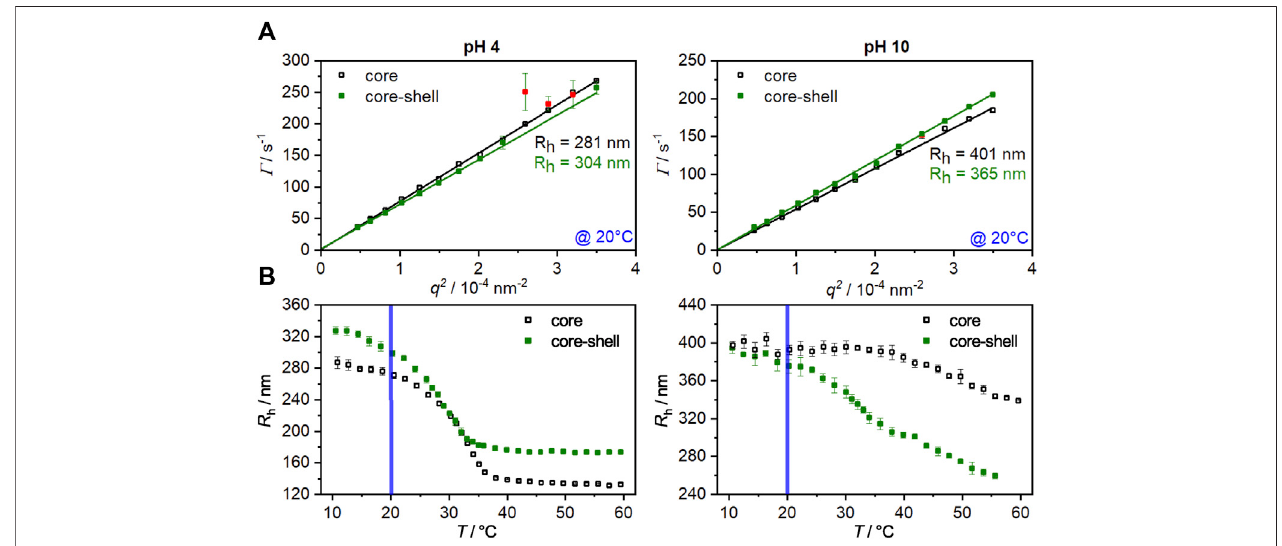
FIGURE 1 | (A) : Angle-dependent PCS measurements for the core (hollow squares) and core-shell particles ( fi lled squares) at pH 4 and pH 10 in the swollen state (20 ° C). The slopes obtained from the linear fi ts were used to calculate the hydrodynamic radius by the Stokes-Einstein equation. Red data points were masked and not used for the fi tting procedure. (B) : Hydrodynamic radii of the core and core-shell microgels as function of temperature. The measurements were performed at a fi xed angleat pH 4and pH 10. The blue line representsthe temperature at which the angle-dependent measurementwereperformed. Theerror bars correspondto the standard